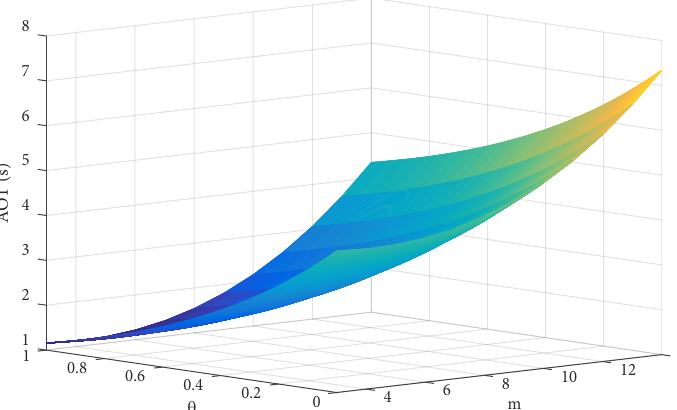
Figure 4. The three-dimensional diagram about AOT, q and m (sources: authors’ own